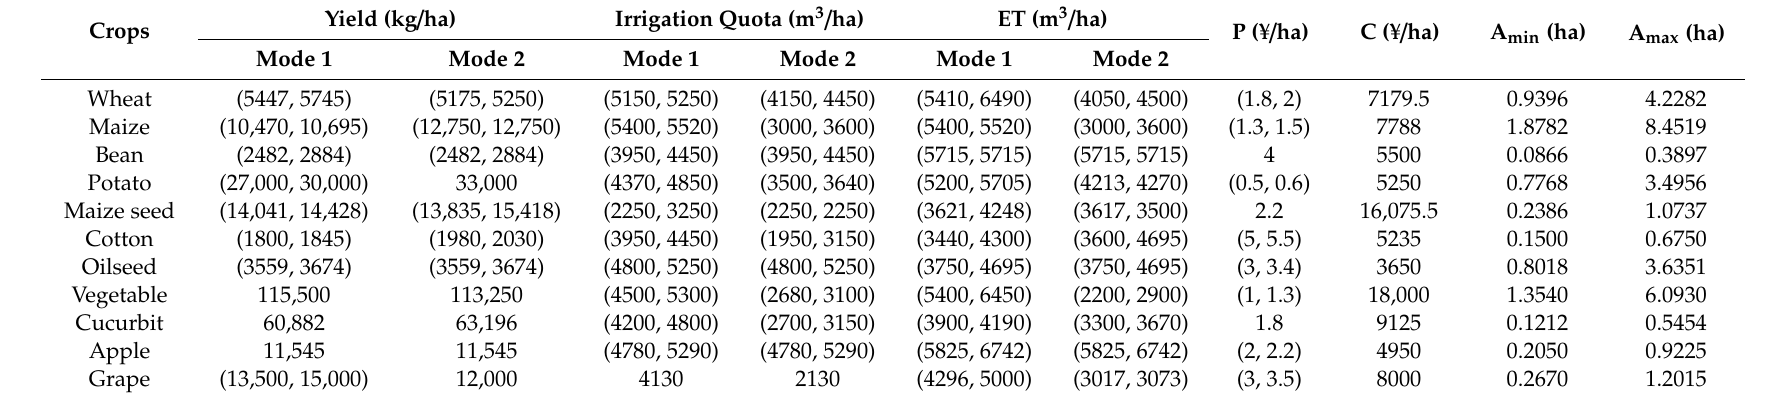
Table 1. The basic crop parameters.